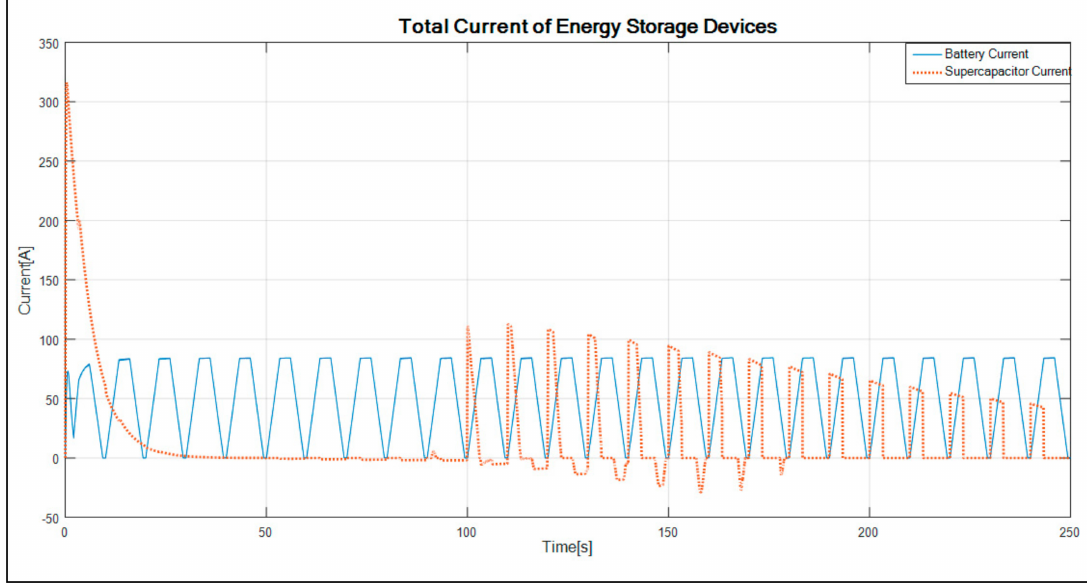
Figure 10. LAB/supercapacitor hybrid current produced by individual Energy Storage